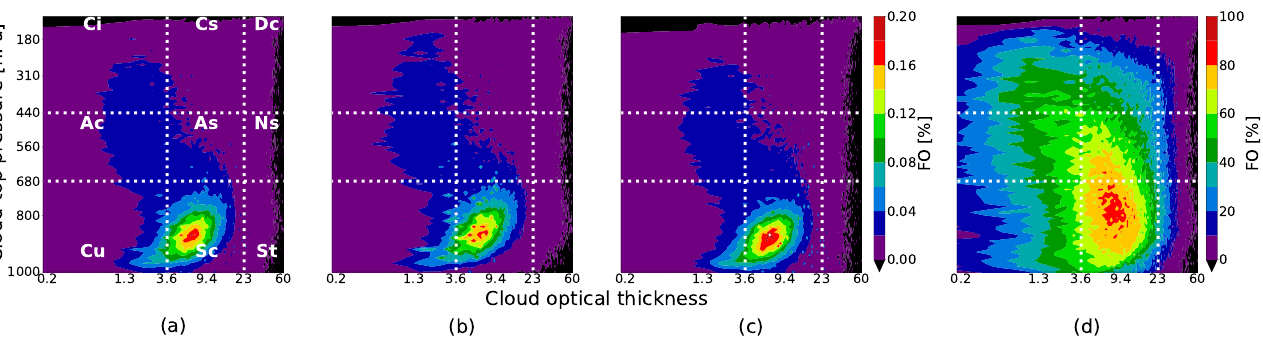
Figure 6. Heatmaps of the relative frequency of occurrence in COT-CTP space for ( a ) observed patches from both January and July, ( b ) values only from January, ( c ) values only from July, and ( d ) cluster counts inclusive of overlap from AICCA 42 . Distributions are smoothed; resolution is 0.5 for COT and 10 hPa for CTP. Panels for observed frequencies ( a – c ) and cluster density ( d ) are expected to have different values. For example, in ( a ), a heatmap value of 0.1% indicates 5895 patches fall in a given histogram bin. In ( d ), a heatmap value of 71% indicates that 30 of 42 clusters overlap with that histogram bin over the range of one standard deviation. The data used here are those used throughout Section 5: all ocean-cloud patches from January and July 2003 from the Terra instrument. White dashed lines show the boundaries of the nine ISCCP cloud classes [3,51]: Cirrus (Ci), Cirrostratus (Cs), Deep convection (Dc), Altocumulus (Ac), Altostratus (As), Nimbostratus (Ns), Cumulus (Cu), Stratocumulus (Sc), and Stratus (St). AICCA 42 clusters cover all nine ISCCP classes, with the largest representation in the Stratocumulus (Sc) category where occurrence also peaks.